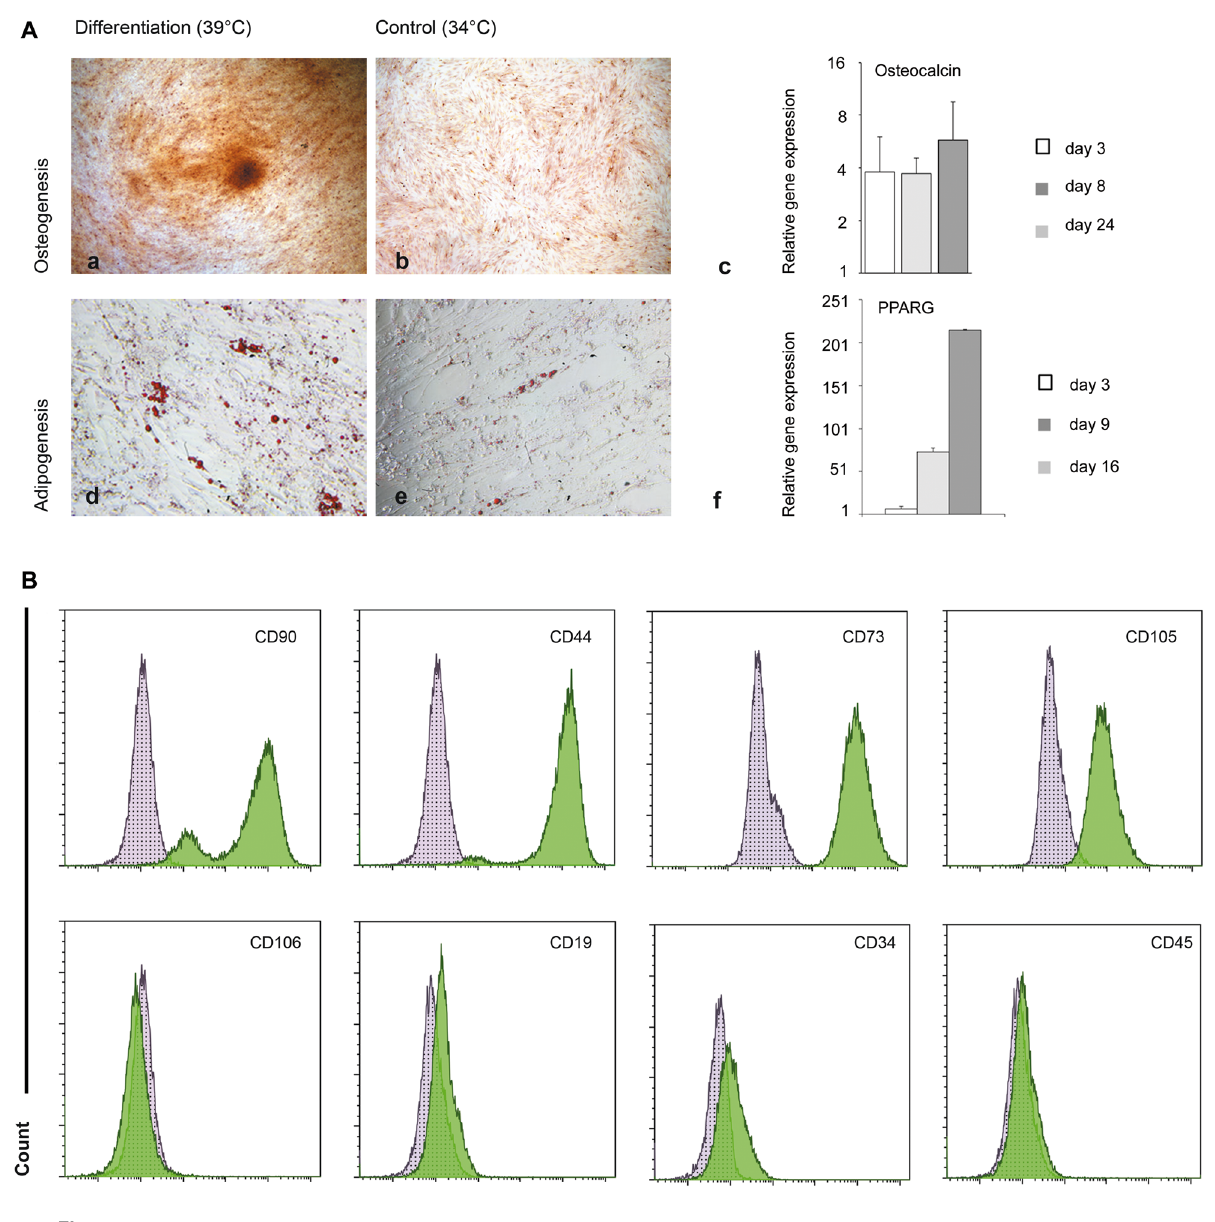
Figure 1. Characterization of hFOB1.19 cells. ( A ) Differentiation capacity towards the osteogenic lineage was tested after cell seeding at a density of 1 × 10 5 cells/cm 2 in DMEM:F12 medium at 34 °C and 5% CO 2 /20% O 2 . (a) The following day osteogenic differentiation was induced by shifting the temperature to 39 °C. After 24 days, cells were stained with Alizarin Red S. (b) As a control, cells were cultivated at 34 °C for 24 days and also stained with Alizarin Red. (c) Corresponding qPCR of the osteogenic marker (Osteocalcin) was normalized to YWHAZ (Tyrosine 3-monooxygenase) gene. (d) In order to examine adipogenic differentiation capacity, cells were seeded at a density of 1.5 × 10 5 cells/cm 2 in DMEM:F12 medium at 34 °C and 5% CO 2 /20% O 2 . Adipogenic differentiation was induced by shifting the temperature to 39 °C and supplementing the medium with the differentiation mix (0.5 mM isobutyl-methylxanthine, 1 µM dexamethasone, 10 µM insulin, 60 µM indomethacin) for 16 days. (e) Adipogenic control cells were incubated in DMEM:F12 medium at 34 °C and 5% CO 2 /20% O 2 for 16 days. (f) Expression levels of the adipogenic marker (PPARg) was assessed by qPCR. For normalization YWHAZ (Tyrosine 3-monooxygenase) was used as a reference gene. ( B ) Cultures of hFOBs at 34 °C, 20% O 2 were subjected to surface antigen analysis by flow cytometry. Flow cytometry was performed using Cytoflex S and the analysis performed with Kaluza software (Beckman-Coulter). Surface antigen in green and isotype control in